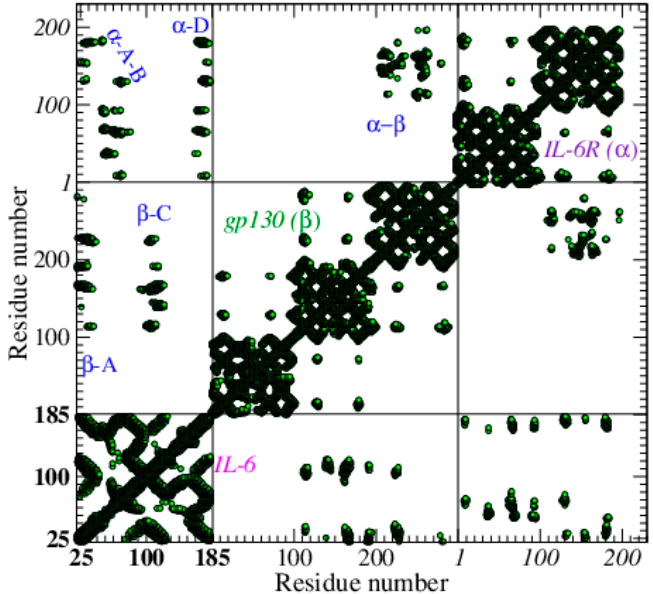
Figure 4. Contact map of IL-6 complexed with its natural receptors, IL-6R, the α -receptor, and gp130, the β -receptor, PDB ID: 1p9m [41], D = 15 Å. The three boxes on the diagonal contain the intra-contacts of IL-6, gp130, and IL-6R, respectively. The outside contacts (between protein and receptors) are in the lateral boxes. Some of the best resolved receptor ( α / β ) –protein contacts are highlighted. Progressive node numbers are indicated for IL-6 (in bold), gp130, and IL-6R (in italic). Both chains H and L contribute to the binding, in all Fabs. All Fabs bind helix D, and the two